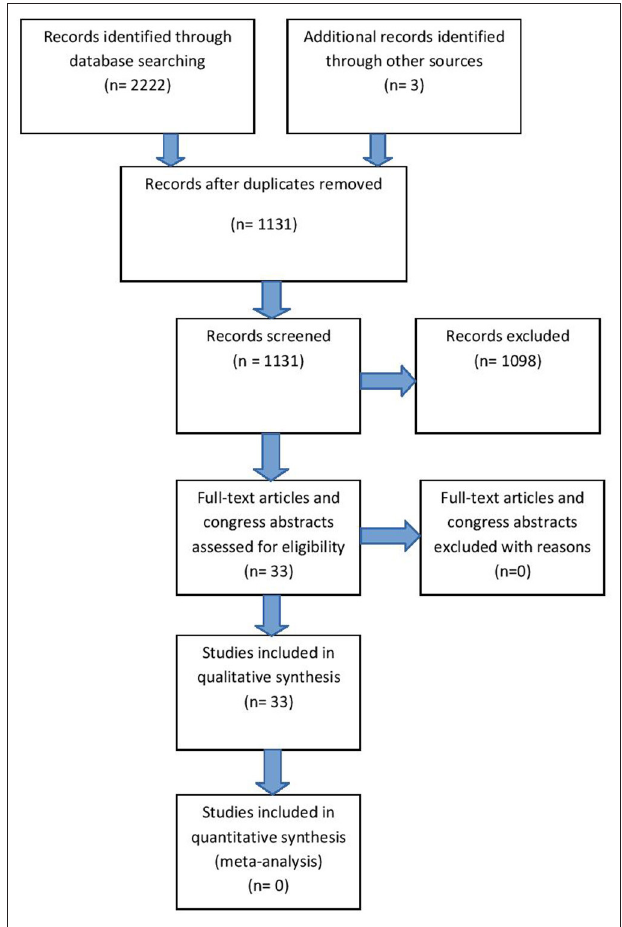
FIGURE 1 | Study flow diagram (From: The PRISMA Group 2009).